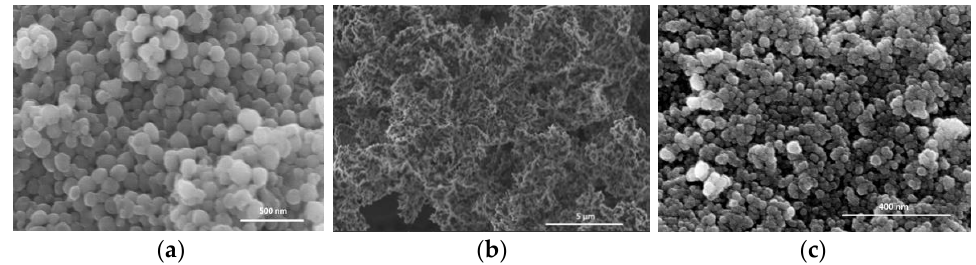
Figure 2. SEM pictures of hydrothermally prepared mesoporous γ -Al 2 O 3 supports: ( a ) E-37, ( b ) W-46, and ( c ) ES-47.